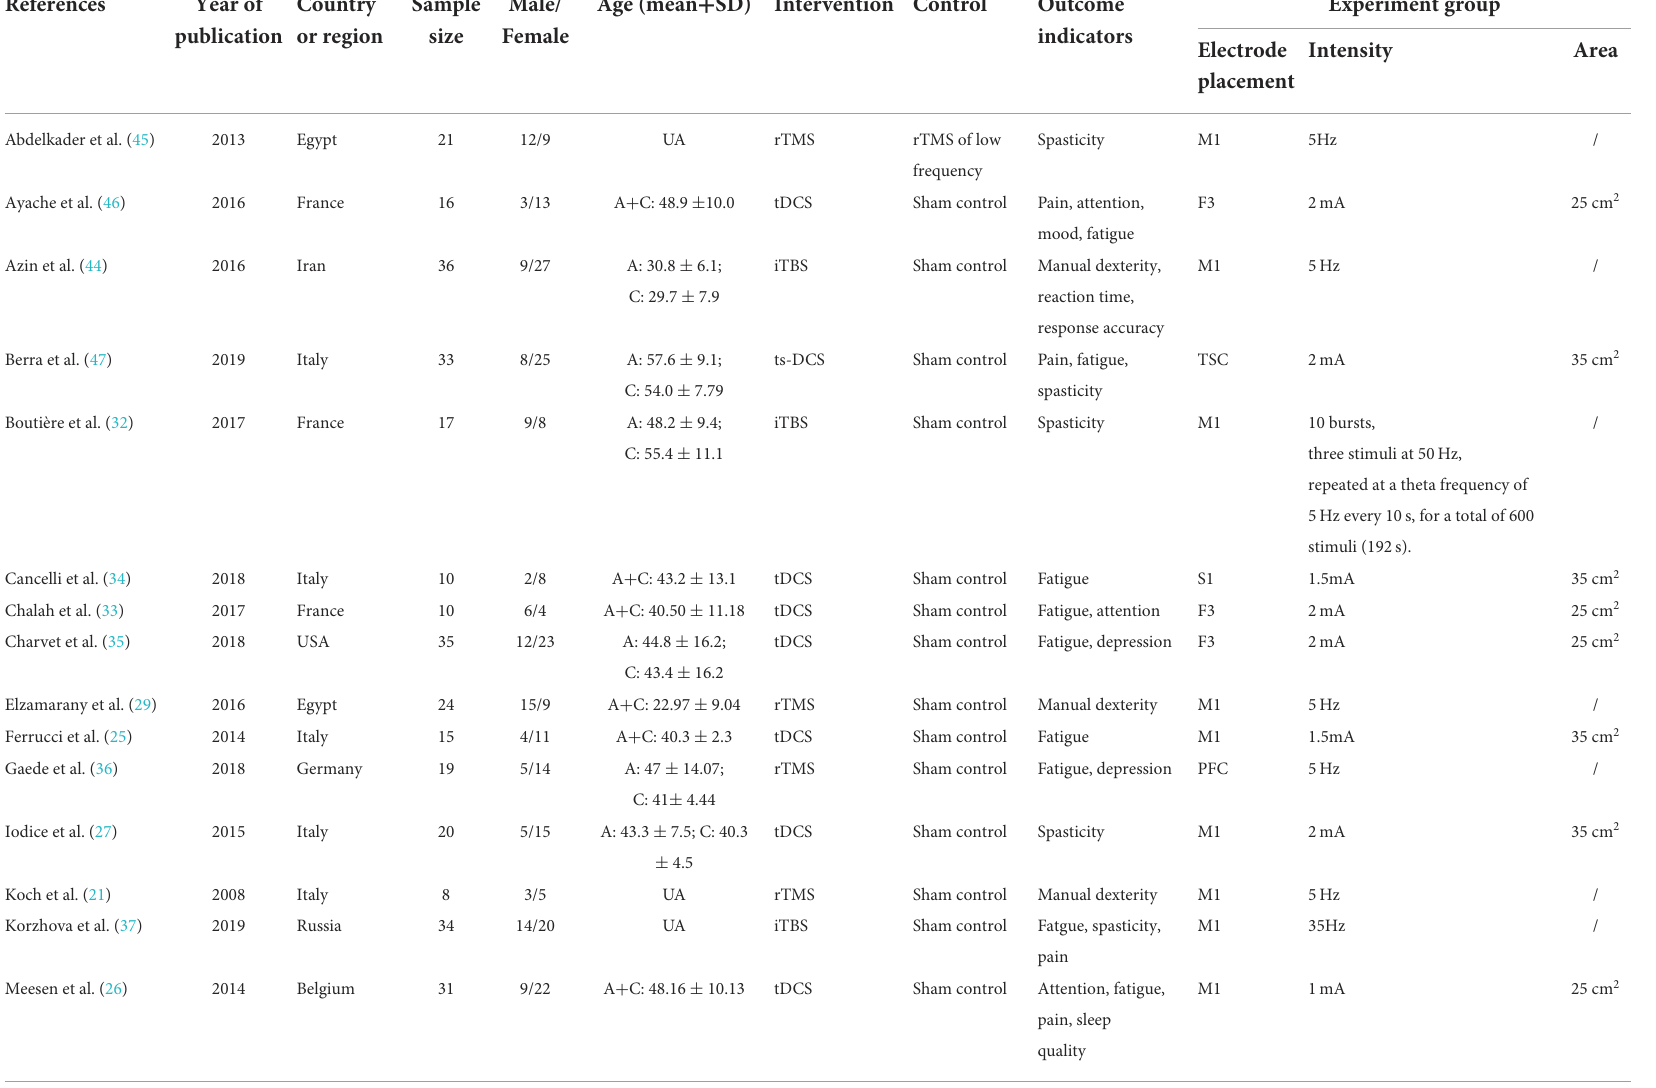
TABLE 1 Characteristics of the studies included in the